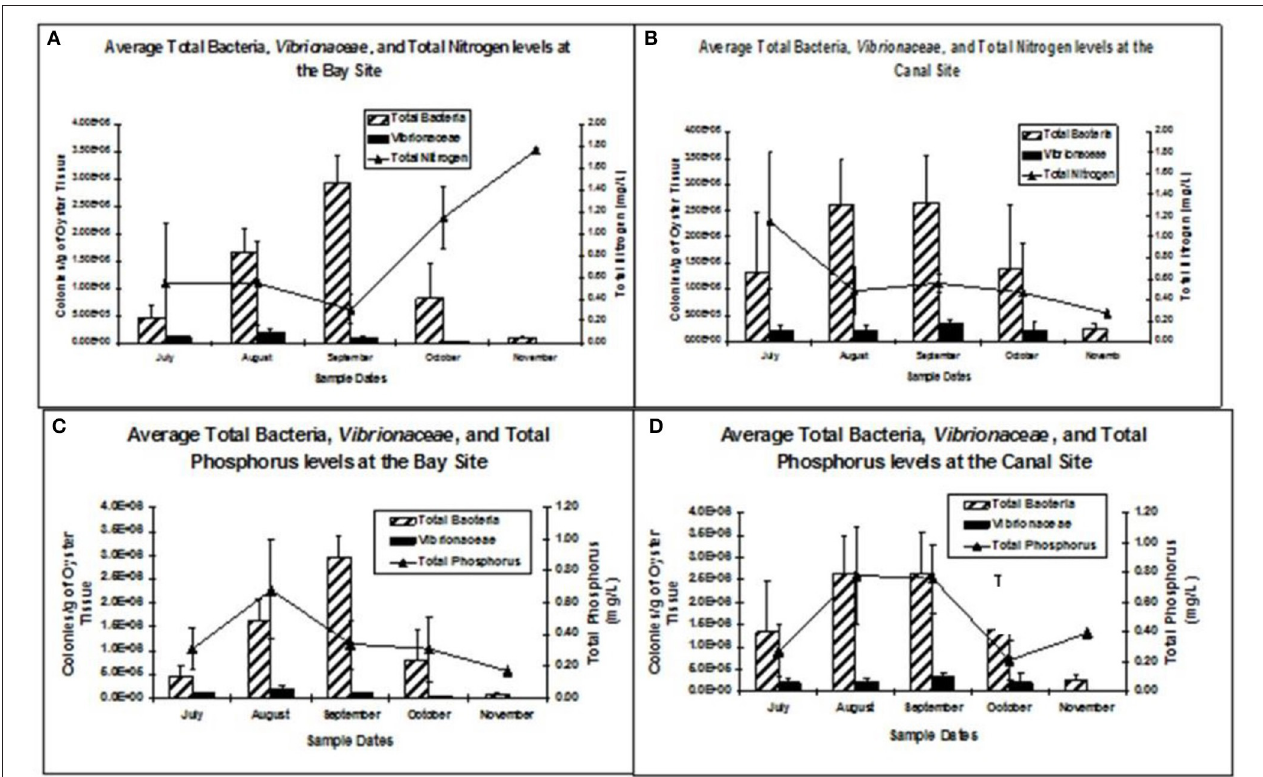
FIGURE 9 | (A) Average total aerobic bacteria and Vibrionaceae levels ( ± standard error) in oysters in relation to total nitrogen levels in the bay and canal study sites (Fay, 2009). (B) . Average total aerobic bacteria and Vibrionaceae levels ( ± standard error) in oysters in relation to total nitrate levels in the bay and canal study sites (Fay,